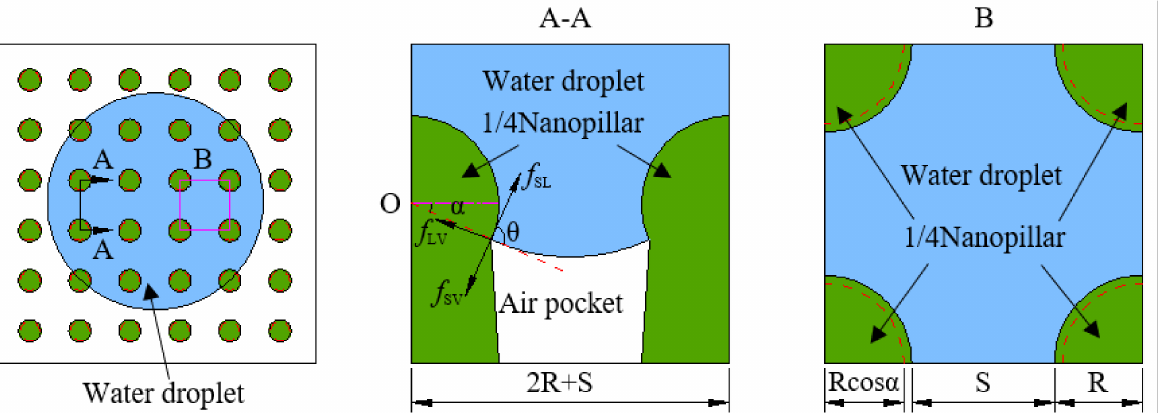
Figure 7. Idealized geometric model of the banana leaves’ abaxial